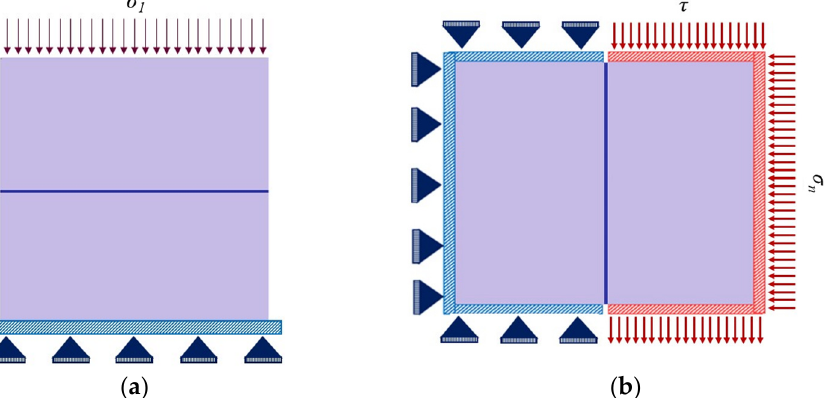
Figure 9. The specimen for ( a ) the unconfined compression test for normal stiffness calibration and